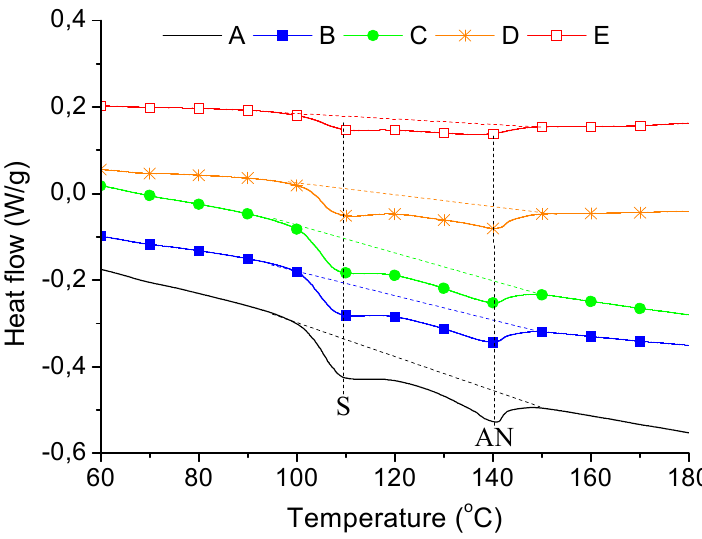
Figure 2. DSC curves for composites A, B, C, D, and E (second heating).